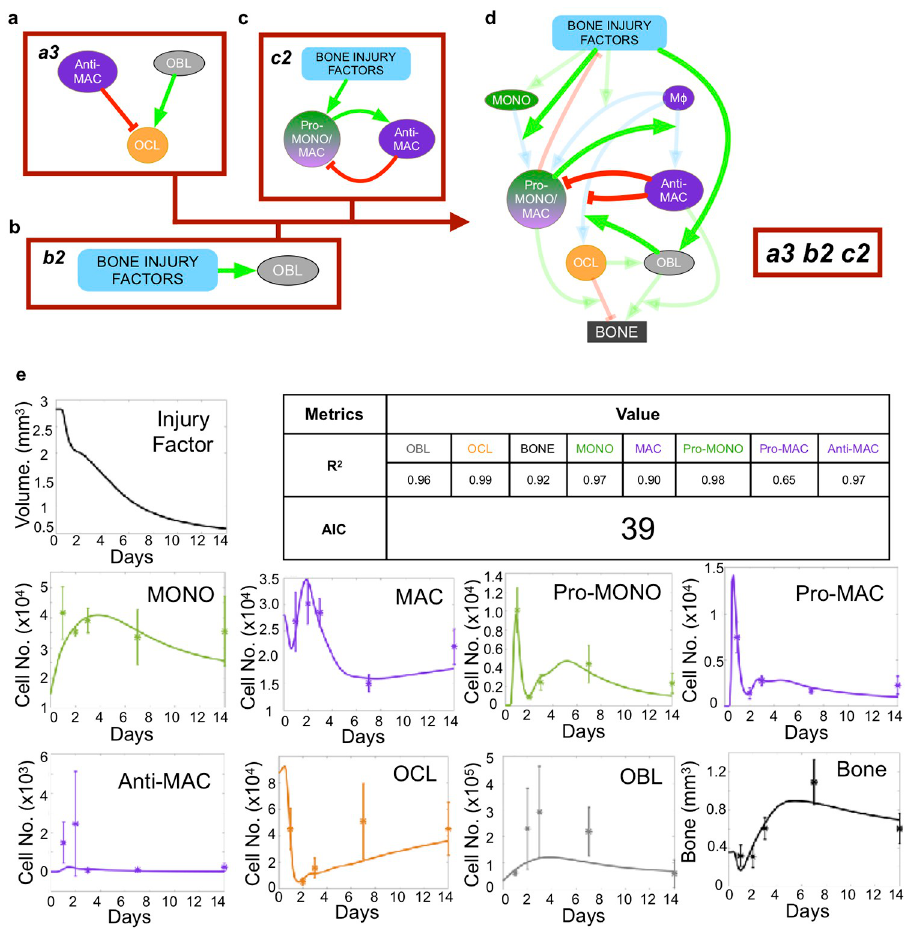
Fig 3. The best fitting hypothesis combination model integrates hypotheses a3 , b2 and c2 (red boxes in a-c ). a mechanism a3 assumes that osteoblasts and anti-inflammatory macrophages promote and inhibit osteoclast formation, respectively. b mechanism b2 assumes that injury factors promote osteoblast expansion. c mechanism c2 assumes that injury factors promote pro-inflammatory monocytes/macrophages polarization. Pro-inflammatory monocytes/macrophages promote anti-inflammatory macrophages polarization, which in return drive depolarization of monocytes/macrophages back to the naive state. d schematic representation of the model using a3-b2-c2 hypothesis combination. Arrows represent positive (green) or negative (red) types of cellular interactions. e Temporal plots and corresponding goodness of fit metrics (AIC and R2s) across all populations, obtained through J 1 minimization.